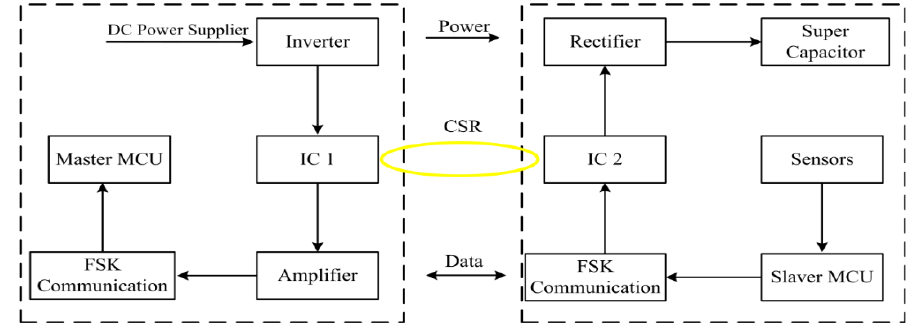
Figure 7. Block diagram of the system